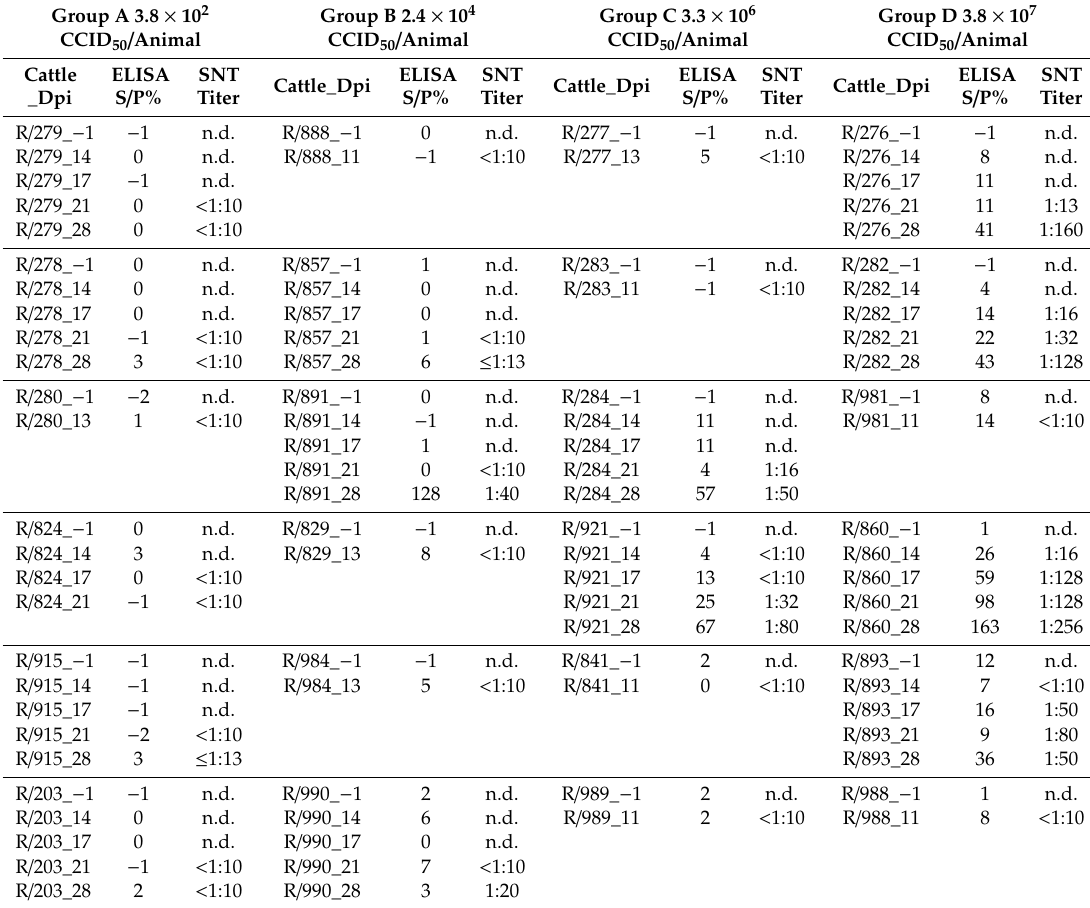
Table 4. Serological results of certain serum samples taken during the animal trial using the ID Screen Capripox Double Antigen ELISA (ID.vet), as well as the serum neutralization test (SNT). Group A 3.8 × 10